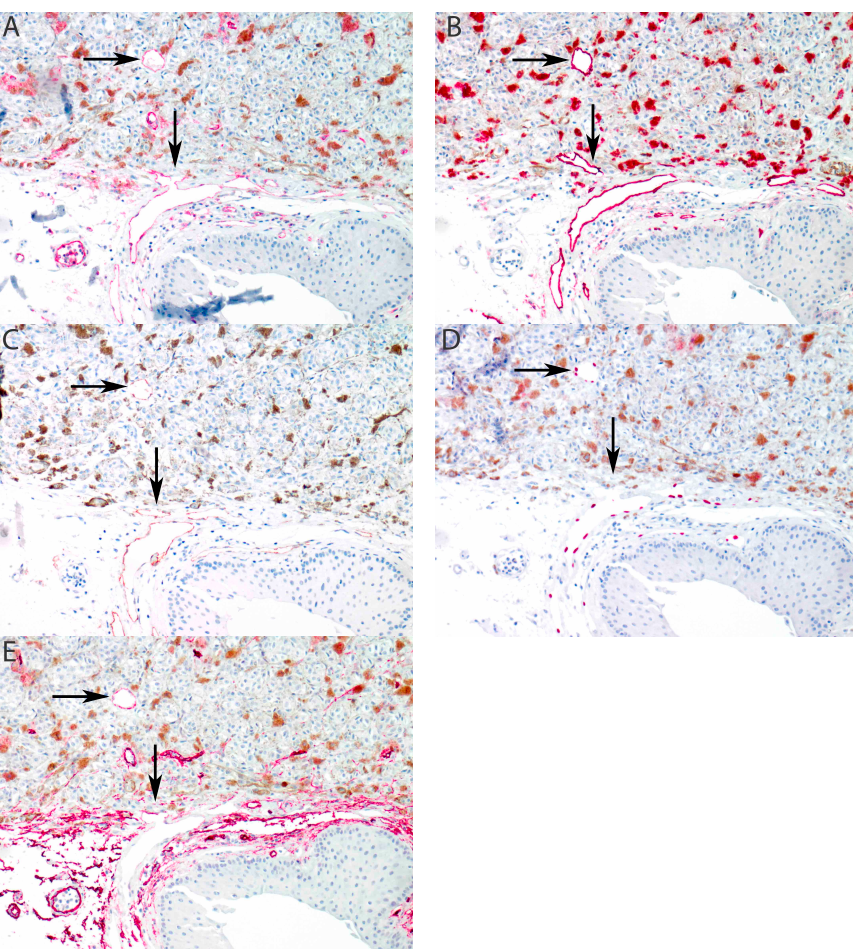
Figure 3. Recruitment of lymphatic vessels into extraocular extension of uveal melanoma (arrows). ( A ) CD31 stains all endothelial cells. ( B ) D2-40 stains conjunctival lymphatic vessel endothelium and